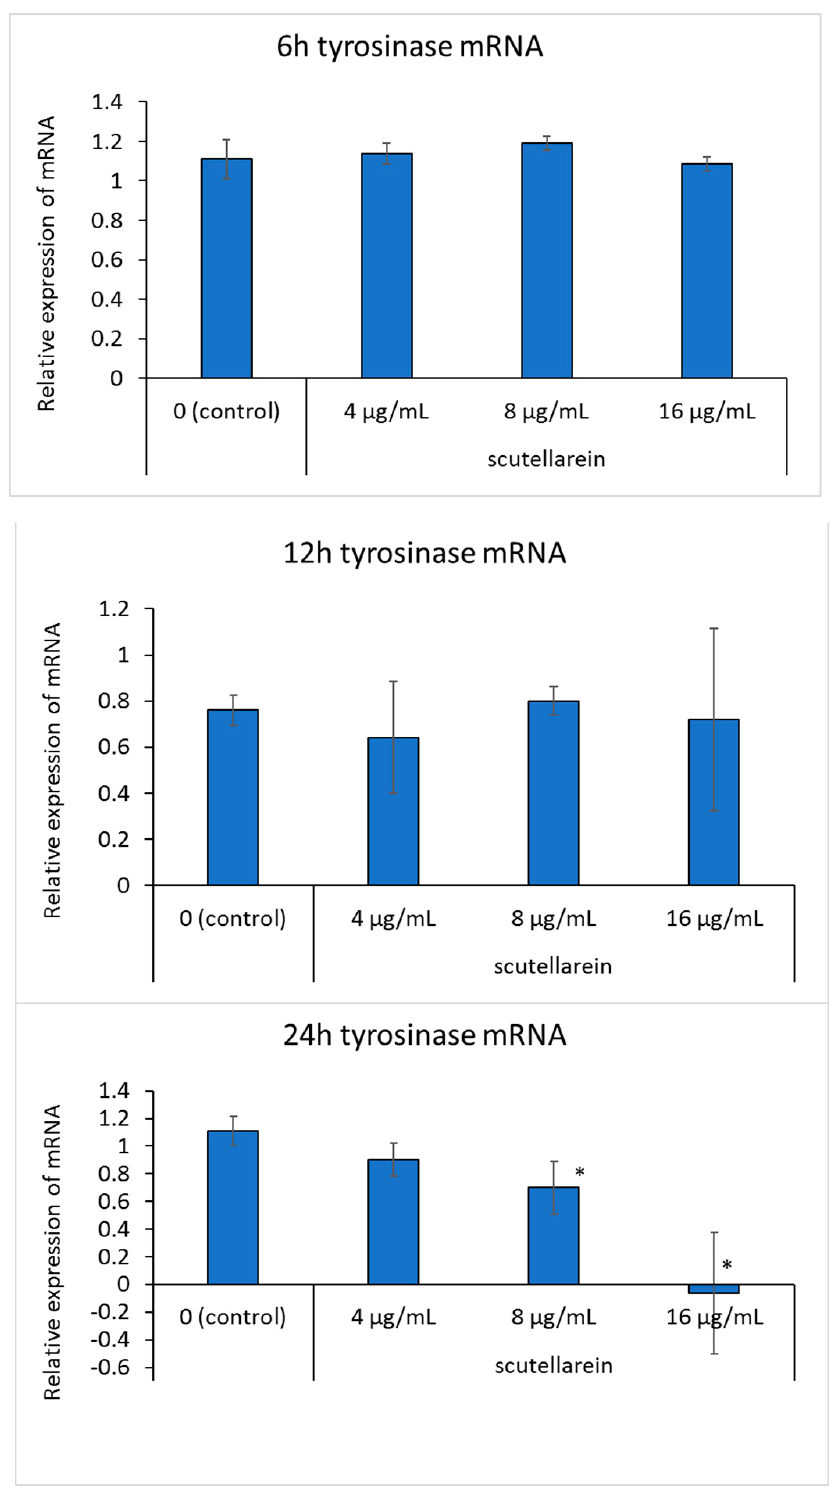
Figure 7. The effects of scutellarein on tyrosinase mRNA expression. B16 cells were treated with different concentrations of scutellarein for 6, 12, and 24 h. RT-qPCR analysis was then performed using the glyceraldehyde-3-phosphate dehydrogenase gene ( GAPDH) as a loading control. Data are presented as the mean ± SD of experiments performed in triplicate. * p < 0.05 compared to the